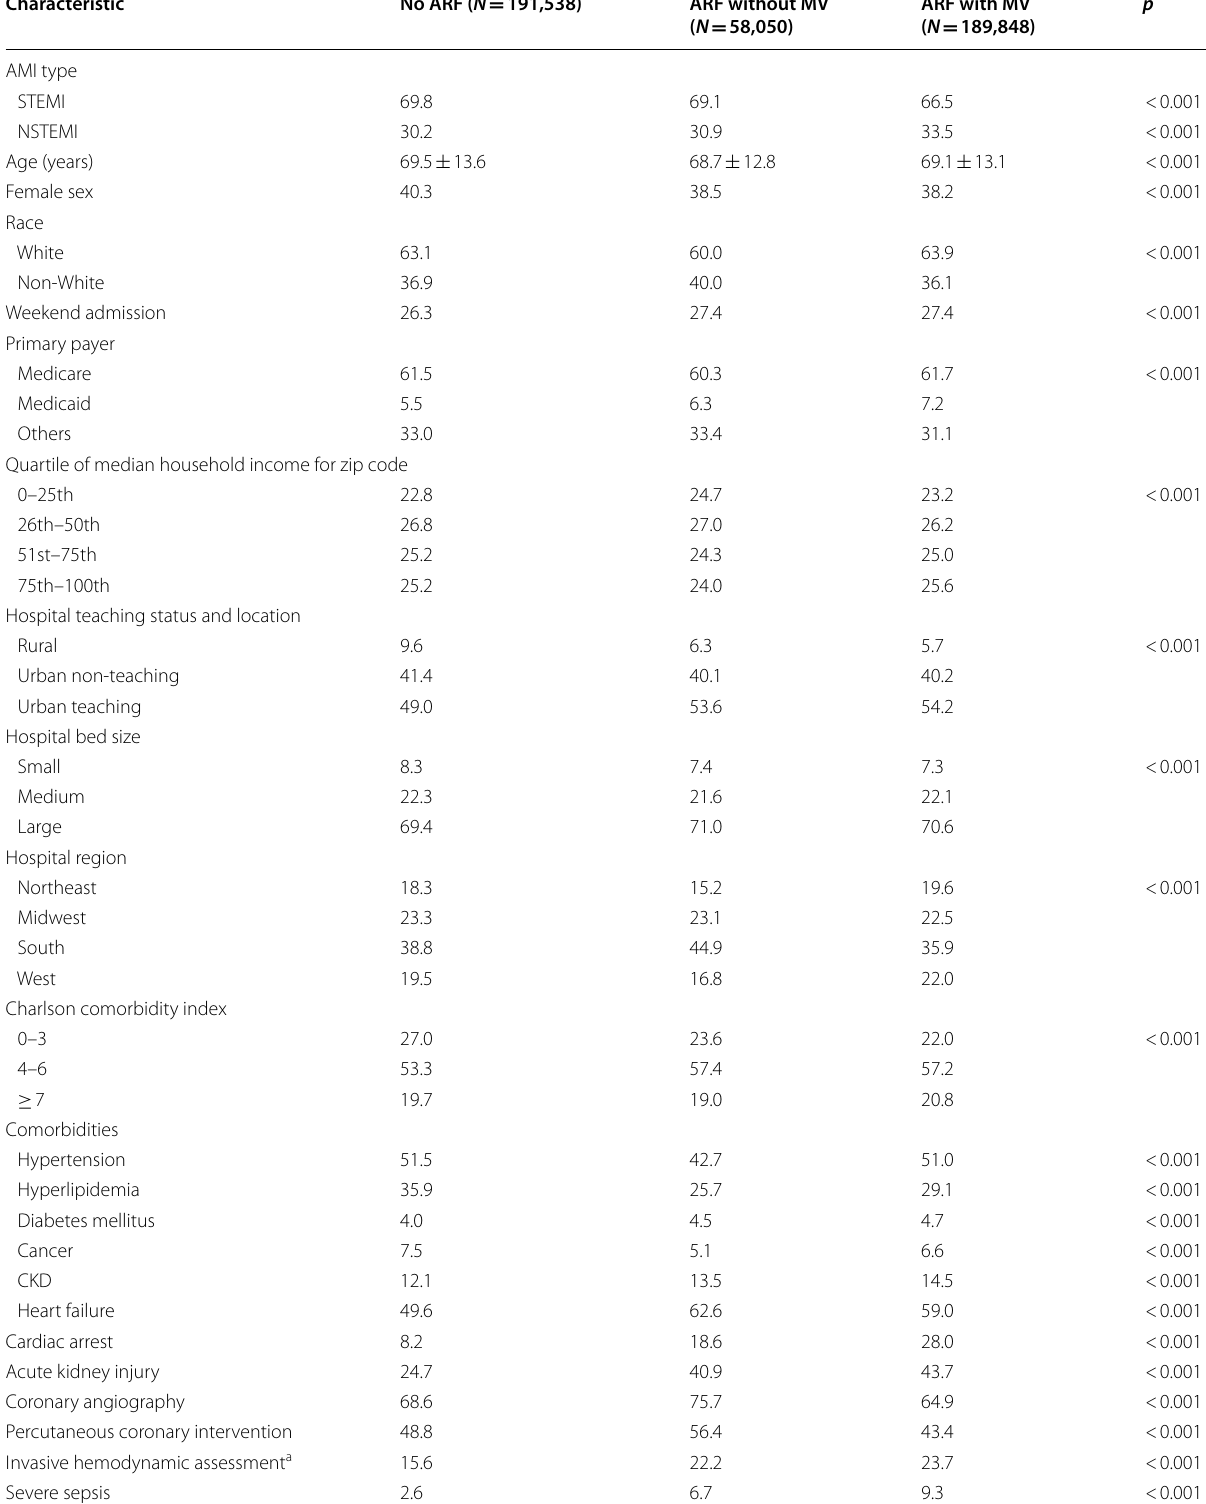
Table 1 Baseline and hospital characteristics of AMI-CS with and without ARF